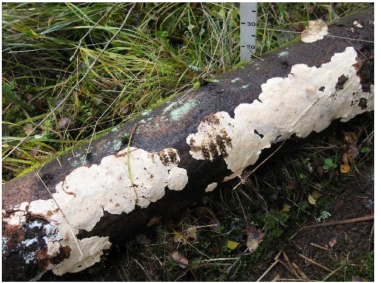
Figure 1. Large Heterobasidion spp. fruitbody.